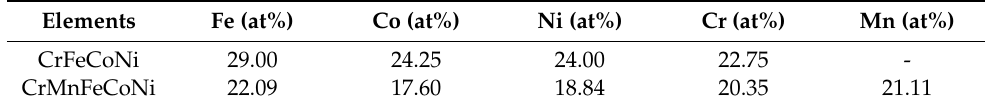
Figure 1. Cross sectional EBSD images of the CrFeCoNi and CrMnFeCoNi coatings: band contrast ( a ) and phase distribution ( c ) of CrFeCoNi coating; band contract ( b ) and phase distribution ( d ) of CrMnFeCoNi coating. Table 2. Chemical compositions of CrFeCoNi and CrMnFeCoNi coatings.